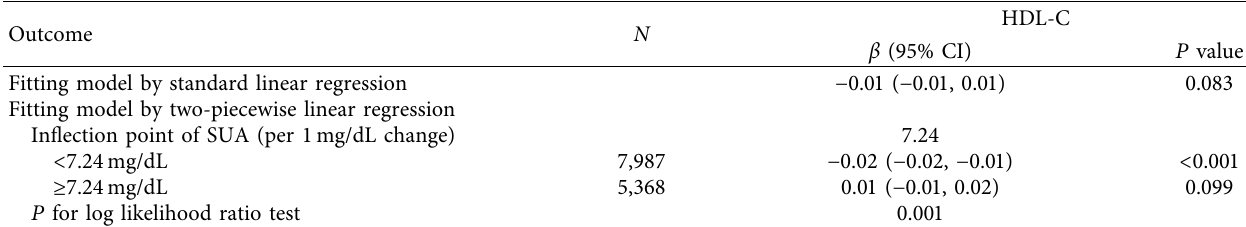
Figure 3: The nonlinear relationship between SUA and HDL-C in a hypertensive population. Adjusted for age, sex, smoking, alcohol use, stroke, diabetes, antihypertensive drugs, lipid-lowering drugs, glucose-lowering drugs, BMI, SBP, DBP, Hcy, FBG, and eGFR. Table 3: The results of the two-piecewise linear